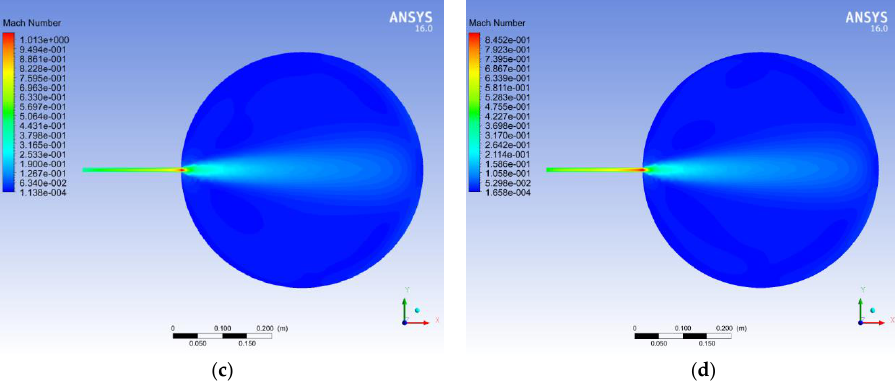
Figure 19. Air inlet with a flow rate of 27 L/min, valve E ( a ) Mach number after 1 s. ( b ) Mach number after 3 s. ( c ) Mach number after 6 s. ( d ) Mach number after 9 s.